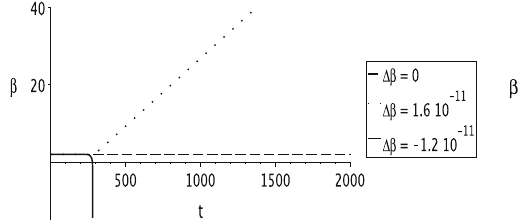
− 0 . 49. The numerical values of H 1 and H 2 coincide with those found from the (13, 14, 15) or (19), (20)) equations. Right panel illustrate motion in the stability